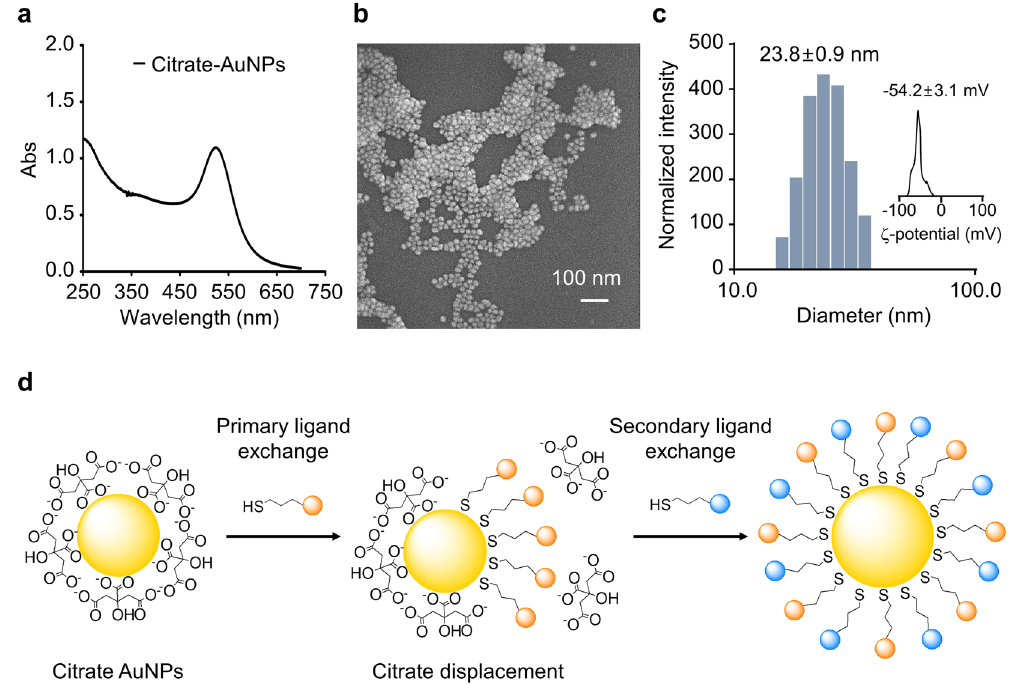
Figure 1. Characterization of gold nanoparticles (AuNPs) and schematics of AuNP modification. AuNPs were synthesized and analysed using UV-Vis spectroscopy ( a ), Field emission scanning electron microscopy (FE- SEM) at 5 kV ( b ), Dynamic laser scattering (DLS) ( c ), and zeta-potential measurements ( c , inset). AuNPs were modified via place-exchange reaction to introduce variously charged ligands ( d